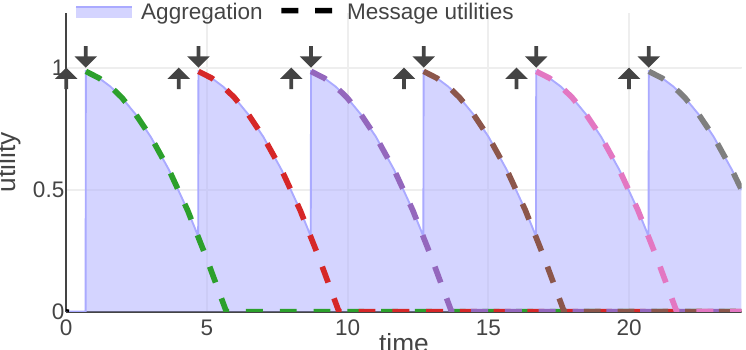
Figure 3. A pos and U pos functions plotted for a mission example. c (cid:13) 2019 IEEE. Reprinted, with permission, from